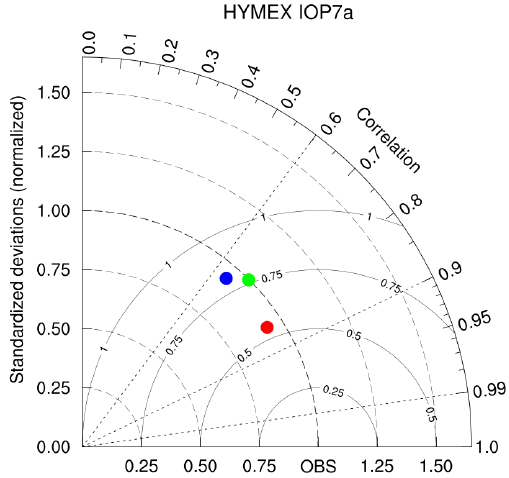
Figure 8. Taylor diagram for the rain accumulation from the three different scenarios: HymRef (in red), HymLow (in blue) and Re- mote (in green). The radial coordinate shows the standard deviation of the rain field, normalized by the observed standard deviation. The azimuthal variable shows the correlation of the modelled rain accumulation field with the observed one. The distance between the reference KED data (i.e. OBS) and individual points corresponds to the root-mean-square error